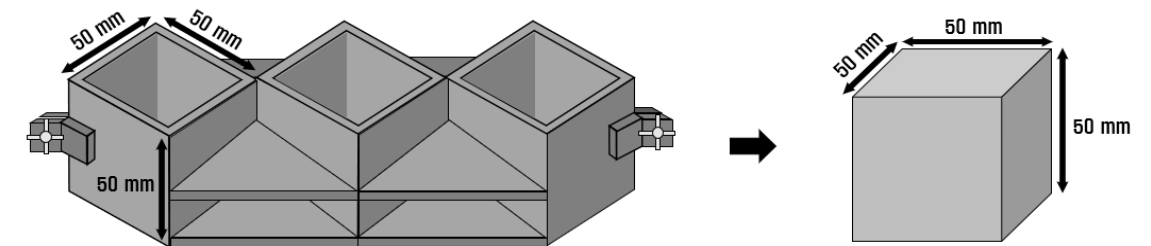
Figure 2. Compressive strength specimen mold.